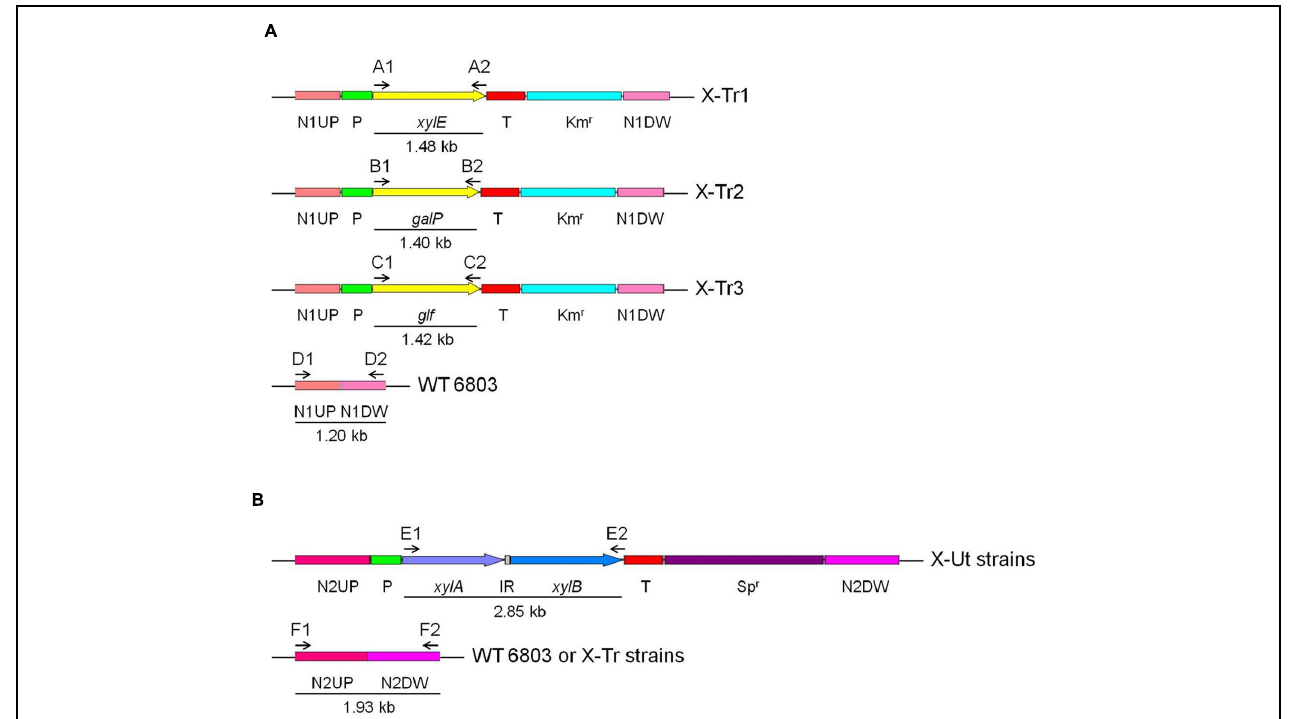
FIGURE 2 | Transformation of Synechocystis strains. All transgenes used in the study were expressed under the control of the psbA2 promoter (Prm) and 5ST1T2 terminator (Trm). Intergenic region (IR), if present between individual genes, is represented as a gray box. Numbered letters and arrows represent the primer sets used to insert genes and evaluate segregation, and the direction of the amplifications, respectively. (A ) Genes encoding the xylose transporters were inserted into neutral site 1 in the wild-type Synechocystis genome using upstream (N1UP) and downstream (N1DW) regions for homologous recombination. The kanamycin resistance cassette (Km r ) was used for selection and segregation of the transformants. (B) The xylAB genes, encoding enzymes that funnel xylose into the pentose phosphate pathway, were inserted into neutral site 2 in the genomes of Synechocystis strains carrying one of the three xylose transporter genes and the wild-type strain using upstream (N2UP) and downstream (N2DW) regions for homologous recombination. The spectinomycin resistance cassette (Sp r ) was used for selection and segregation of the transformants.